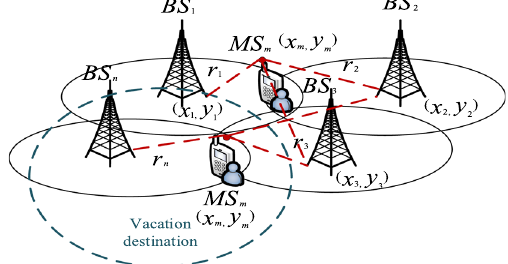
Fig. 6 TDOA data fusion using multiple